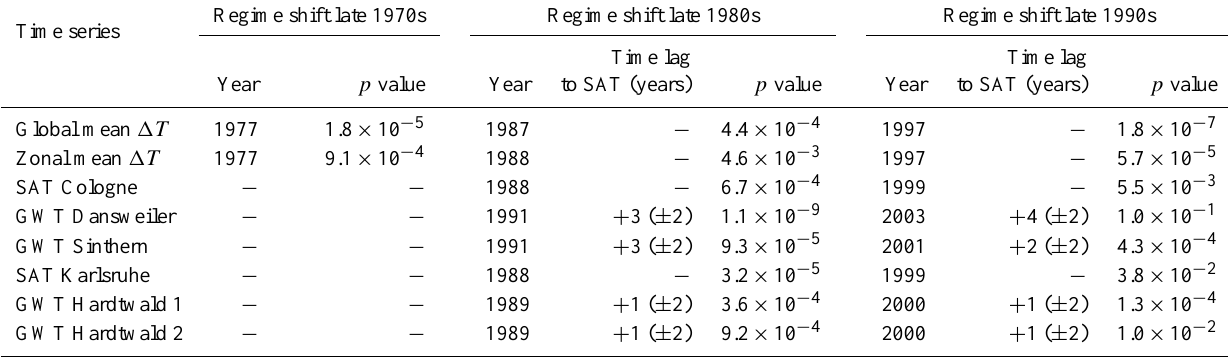
Table 4. Time lags and final p values of the observed regime shifts in air and groundwater temperature. The specific years indicate the first year of the new regime. Time lags are defined as the period between the occurrence of a regime shift in local SAT and the corresponding successive shift in